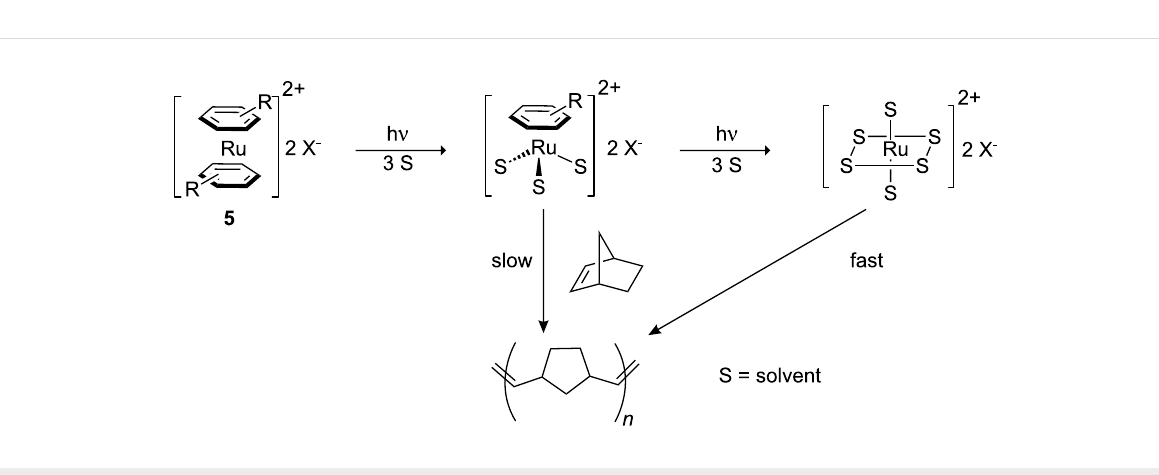
Scheme 3: Proposed mechanism for photoactivation of sandwich